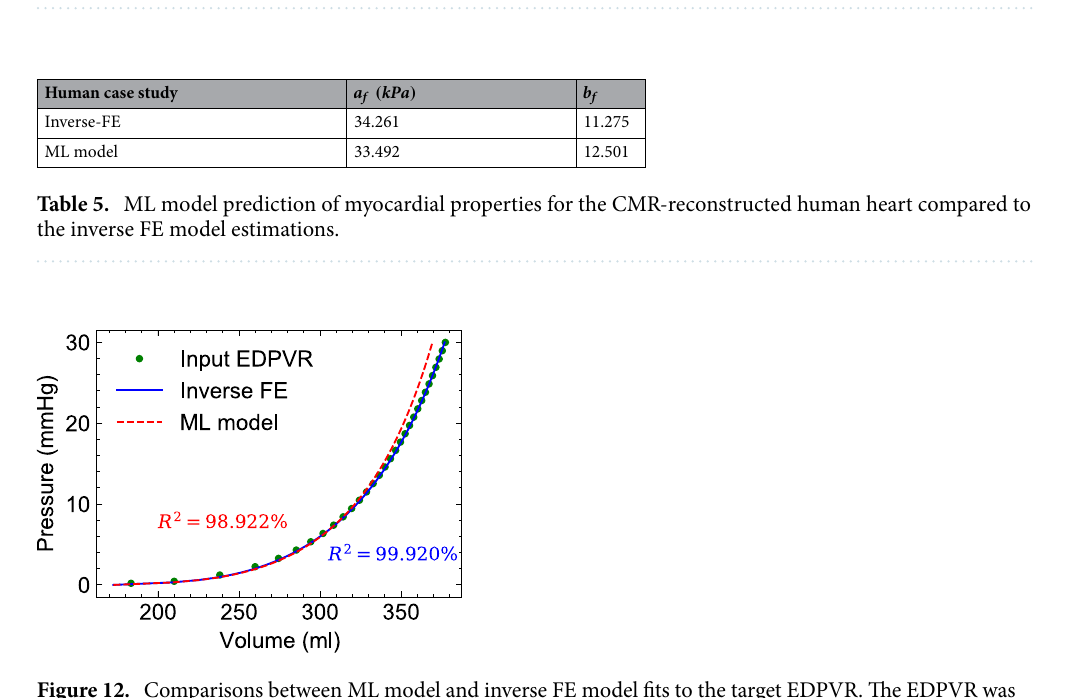
Figure 11. Stress-stretch response of rat LVFW myocardium under equibiaxial testing. The corresponding response predicted by the ML model is included for comparison.